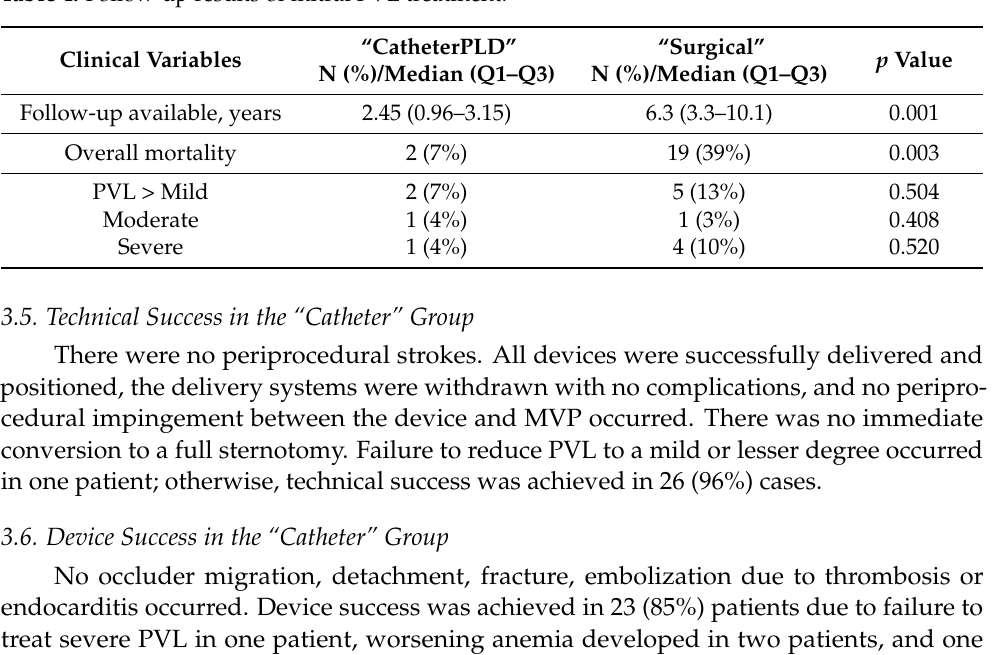
Table 4. Follow-up results of mitral PVL